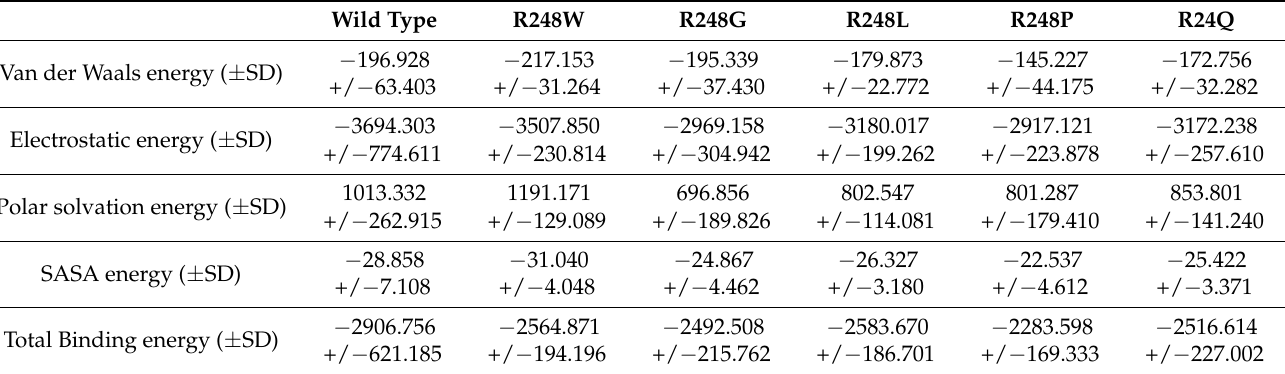
Table 3. Overall binding free energies of DNA to various R248 mutant-p53 protein complexes using MMPBSA calculation, where the binding free energy is mentioned in kJ/mol. Wild Type R248W R248G R248L R248P R24Q